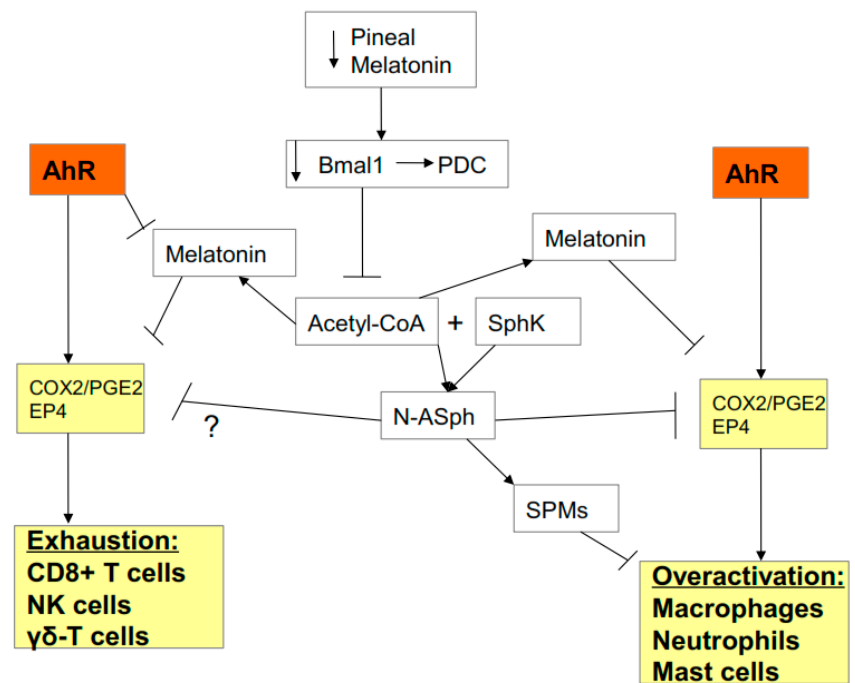
Figure 6. AhR-induced cyclooxygenase (COX) 2 / PGE2 / EP4 has di ff erential e ff ects in anti-viral cells vs. cells of the ‘cytokine storm’. Levels of acetyl-CoA may be significant determinants of AhR e ff ects via the COX2 / PGE2 / EP4 pathway via acetyl-CoA using sphingosine from sphingosine kinase (SphK) to produce N-acetyl-sphingosine (N-ASph), which, like aspirin, acetylates and inhibits COX2. Acetyl-CoA, as a co-substrate for AANAT, also increases melatonin, which also inhibits this AhR-driven pathway. As such, acetyl-CoA may act to co-ordinate N-ASph and melatonin production and e ff ects, with their di ff erential consequences in NK cells and CD8 + t cells vs. macrophages, neutrophils, and mast cells. This would suggest that variations in acetyl-CoA in these cells will determine their di ff erential activation in SARS-CoV-2 infection, as well as in cancers. The suppression of melatonin by the AhR in all of these cell types will contribute to their dysregulation in SARS-CoV-2 infection, whilst the suppression of pineal melatonin, via a decrease in Bmal1-induced PDC and therefore acetyl-CoA production, will be important in driving the dysregulated immune response in the aged population as well as in those with high-risk, pre-existent medical conditions. N-ASph can also increase SPMs in macrophages, which, along with autocrine melatonin, switches activated macrophages to a more quiescent phagocytic